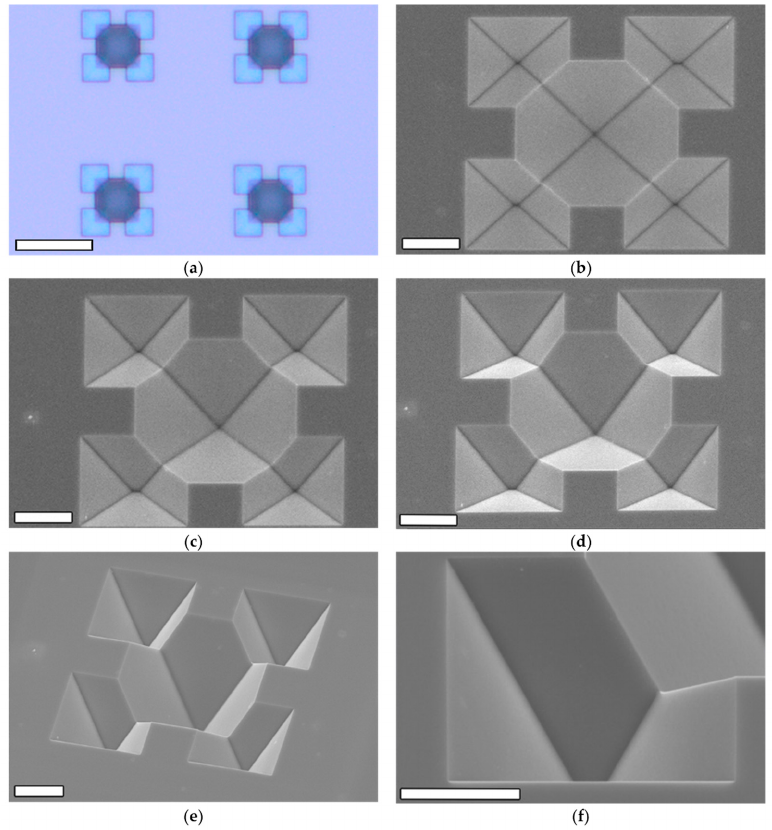
Figure 13. G2 after 125 min of etching in TMAH (25% 70 °C). ( a ) Top-view taken with an optical microscope through the SiO 2 hard-mask. ( b – e ) SEM images with a tilt of 0°, 10°, 20°, and 40°, re- spectively, with ( e ) also rotated after stripping the SiO 2 hard-mask for taking the images. ( f ) Zoom- in of a G2 of the left bottom corner with a 40° tilt. Scalebars: ( a ) 10 µm and ( b – f ) 2 µm.